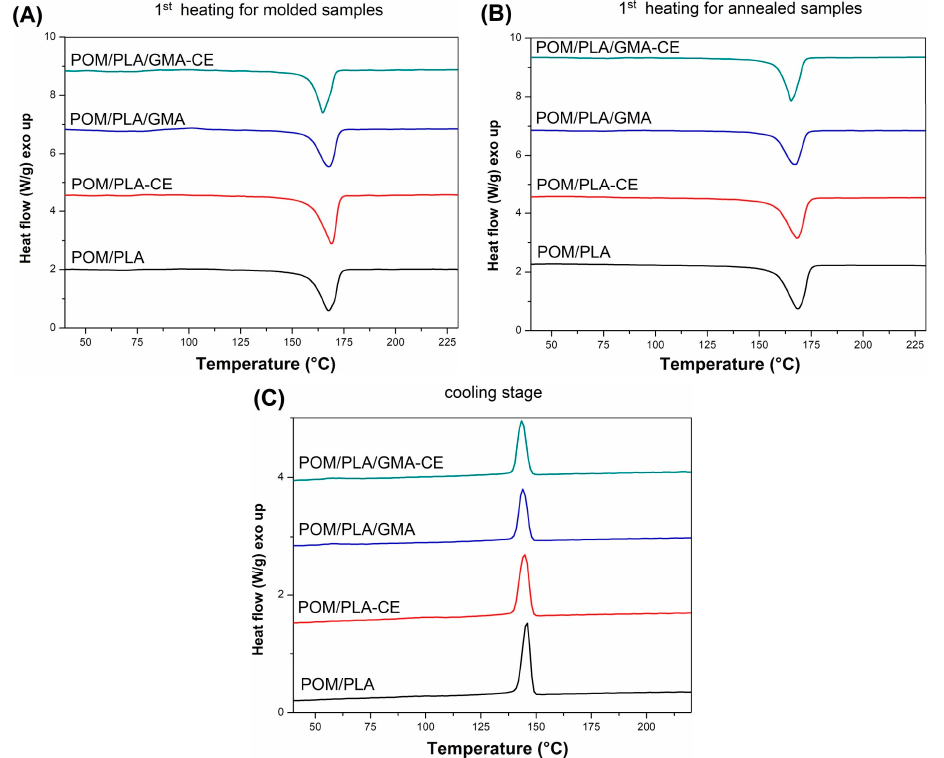
Figure 14. First heating thermograms for polymer blends: molded ( A ) and annealed ( B ) samples, and cooling stage ( C ). and cooling stage ( C